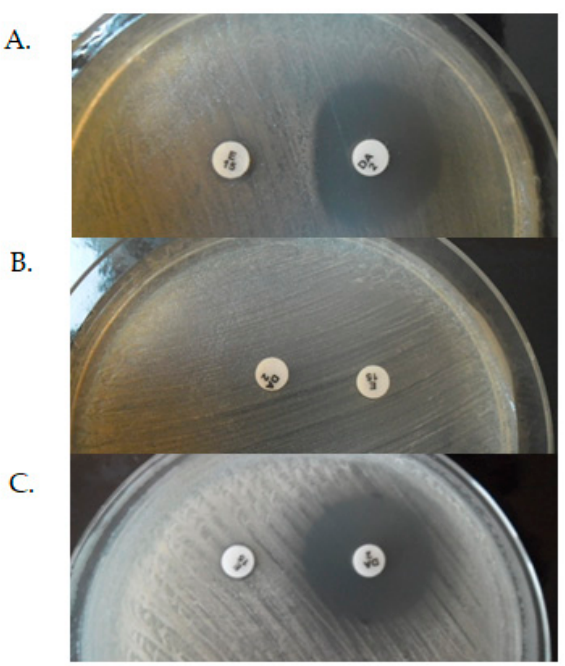
Figure 7. Inductive ( A ), constitutive ( B ), and MS B ( C ) phenotypes of MLS B resistance as determined by D ‐ test (E ‐ erythromycin, DA ‐ clindamycin). The photos come from the author’s private archive.